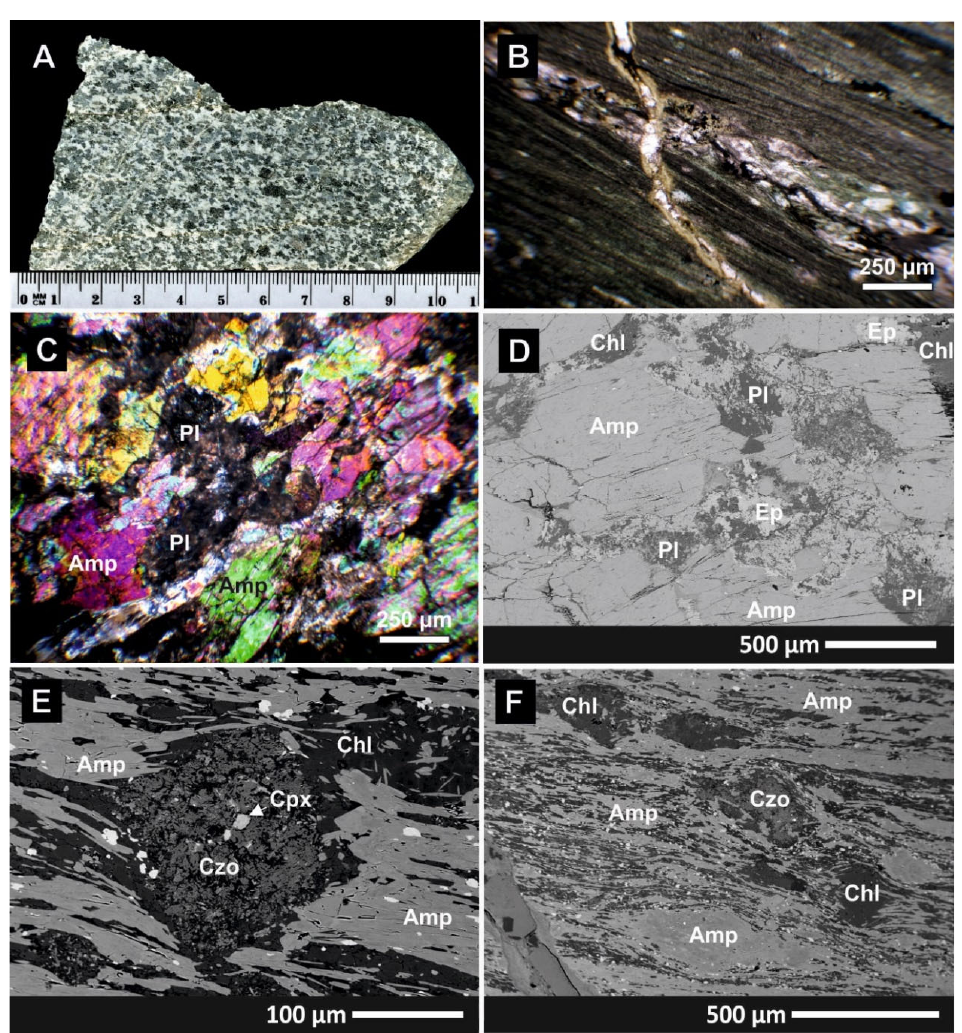
Figure 18. Macroscopic ( A ), PL microscopic ( B , C ), and BSE ( D – F ) images of amphibolites from the inferred ophiolitic thrust ‐ sheet hanging walls. ( A ) Slightly anisotropic amphibolite texture in coarse ‐ grained amphibolite part composed of Amp and Pl with magmatic Cpx relics (P12A). ( B ) Fine ‐ grained shear bands of amphibolites (P10F). ( C,D ) Texture of coarse ‐ grained amphibolite layers with Amp ‐ preferred orientation (P12A). Recrystallization aggregates of Chl, Tr, Act, Ep, Czo, Ab, and Ttn in grain boundaries of Mhb, Prg, and Pl. ( E ) Porphyroclast of idiomorphic Czo pseudo ‐ morph with the inferred magmatic Cpx relics in the middle (P10F). ( F ) Porphyroclasts of Mhb and Prg in sheared matrix of recrystallized Mhb and Prg, associated with Tr, Act, Ep, Czo, Phg, Ab, and Chl (P10F). Picture ( B ) at II P; ( C ) at X P.